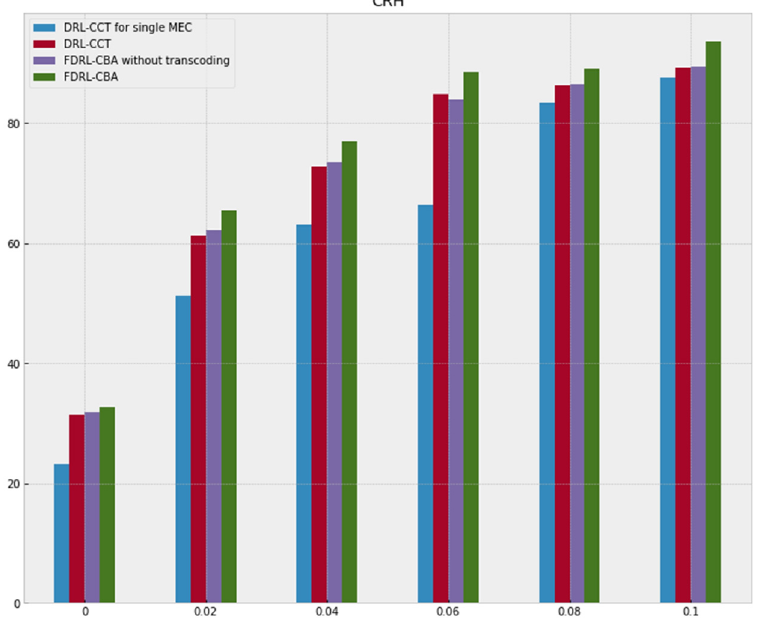
Figure 6. Comparison of cache hit ratio in different cache ratios among the four algorithms.